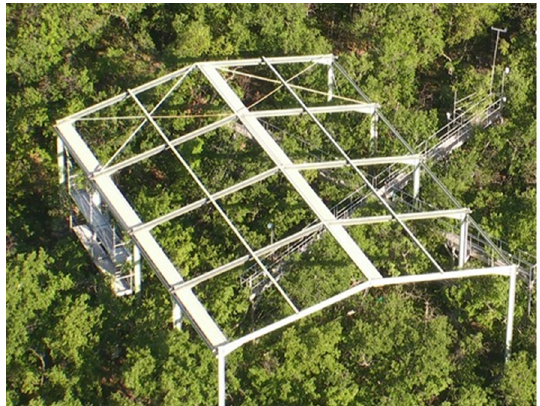
Figure 1. Oak Observatory of the Observatoire de Haute-Provence (O 3 HP). 43°56′06.74″ N, 5°42′38.57″ E. Rain exclusion device and the scaffolding for canopy